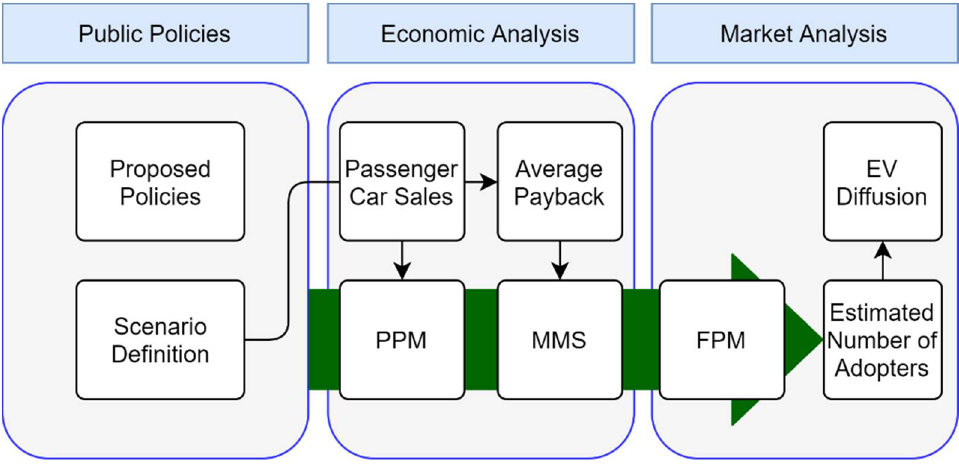
Figure 1. Flowchart of the proposed methodology.